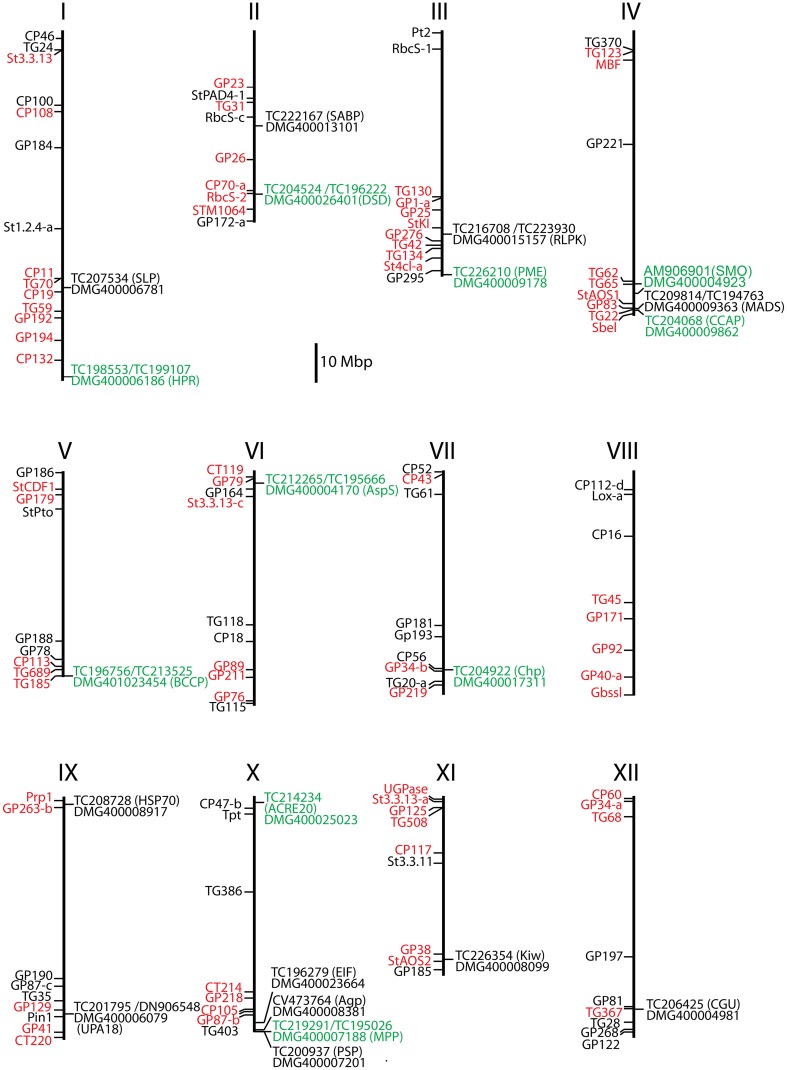
Positions of 21 selected candidate genes on the physical maps of the 12 potato chromosomes. Gene Pubq was not present on the physical map. RFLP (restriction fragment length polymorphism) markers linked to resistance QTLs are shown in red and additional anchor markers in black to the left of each chromosome map (Gebhardt, 2013). Candidate locus name, matching transcript number, and gene acronyms (in parenthesis) are shown to the right. Loci where one or more SNPs were associated or linked with MCR and rAUDPC are highlighted green.